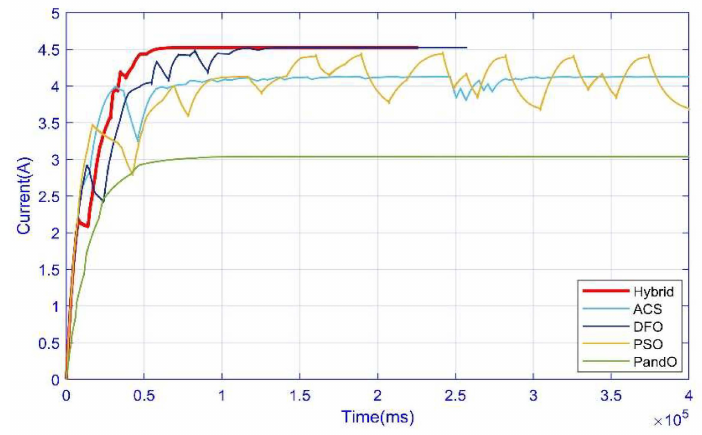
Figure 19. Case 4: Current comparison of hybrid with other